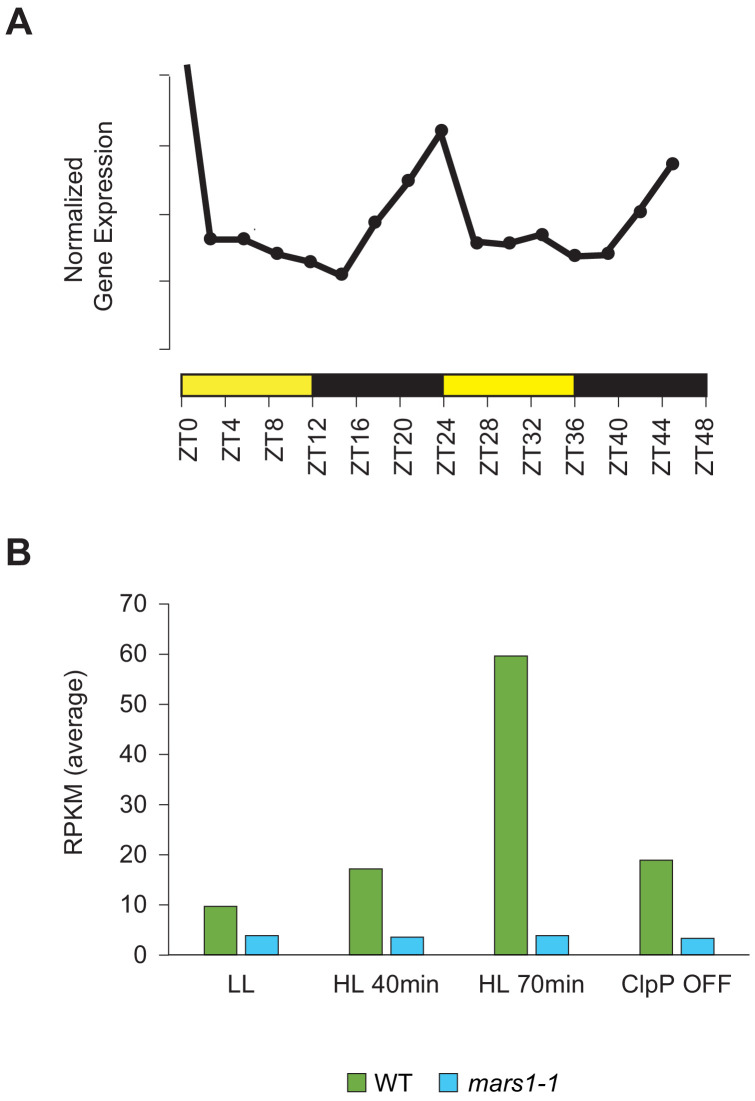
MARS1 gene expression pattern.(A) MARS1 mRNA expression profile according to CircadiaNET, a web-based developed tool integrating RNA-Seq data generated over 24 hr periods in neutral day conditions (12 hr light/12 hr dark) from the eudicot Arabidopsis thaliana and the microalgae Chlamydomonas reinhardtii and Ostreococcus tauri. (http://viridiplantae.ibvf.csic.es/circadiaNet/index.html). MARS1 gene shows a circadian expression pattern (p-value of 1.53 e-11) and clusters with a group of 1212 genes exhibiting their expression peaks at dawn and their expression troughs at night (http://viridiplantae.ibvf.csic.es/circadiaNet/clusters/cre/cre_trough_dark_peak_dark_light.html). (B) MARS1 mRNA expression level (average Reads Per Kilobase Million –RPKM-) in WT and mars1-1 mutant subjected to high light treatment for 40 or 70 min or to ClpP1 down-regulation for 68 hr. (Raw values are available in Figure 5—figure supplement 2—source data 1 and Supplementary file 2).Figure 5—figure supplement 2—source data 1.MARS1 transcript levels (RPKM values).